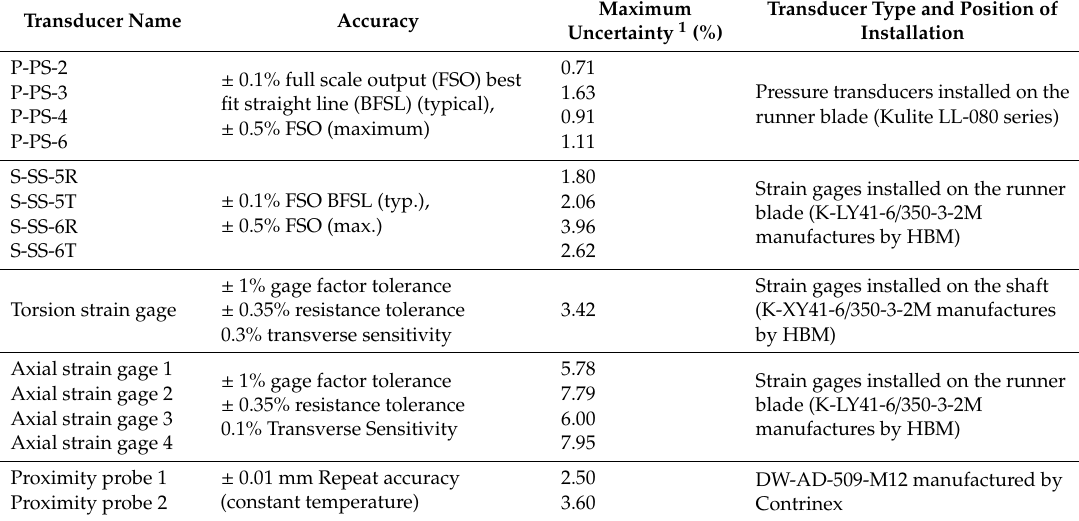
Table 2. Accuracy and uncertainties of the pressure transducers and strain gages installed on the turbine runner blade and